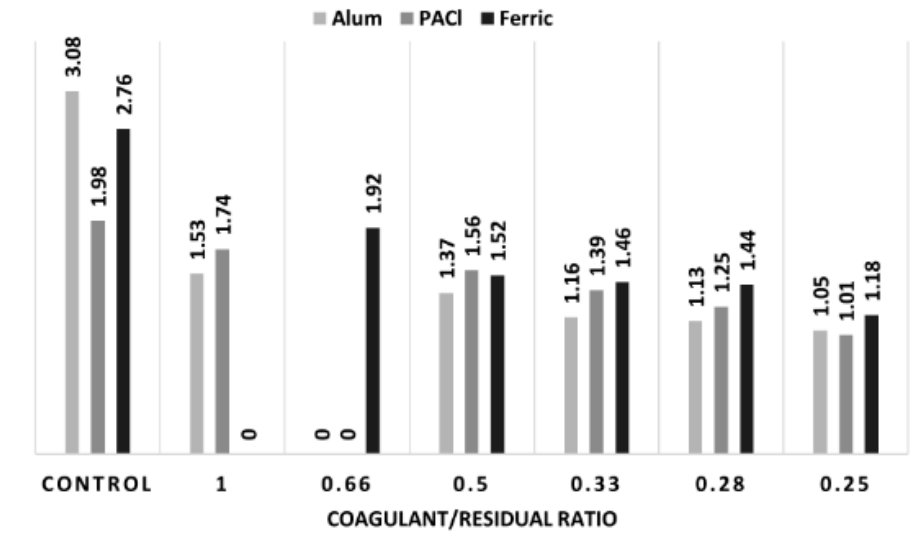
Figure 5. Iron residual removal using selected five C / R ratios.